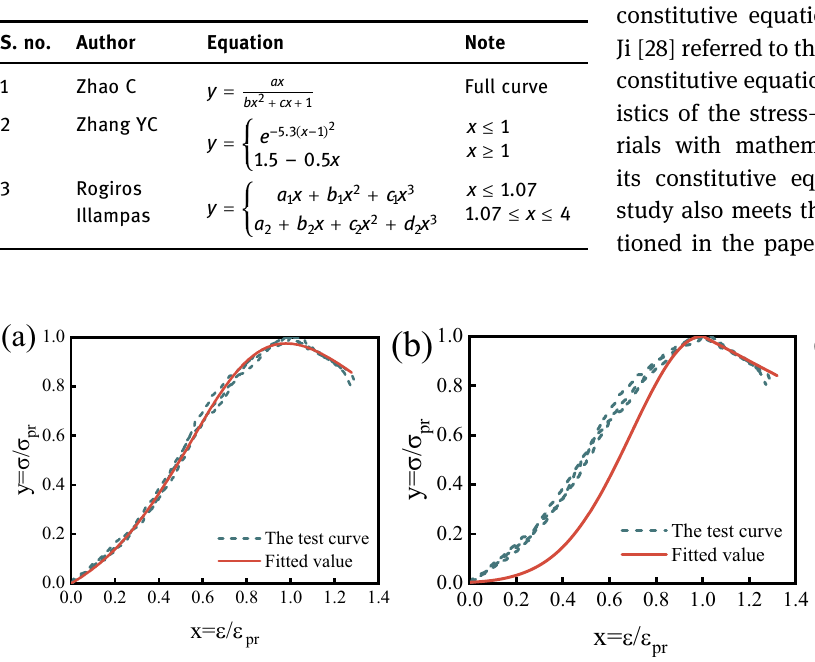
Figure 10: Comparison of constitutive models: ( a ) Zhao C, ( b ) Zhang YC, and ( c ) Rogiros